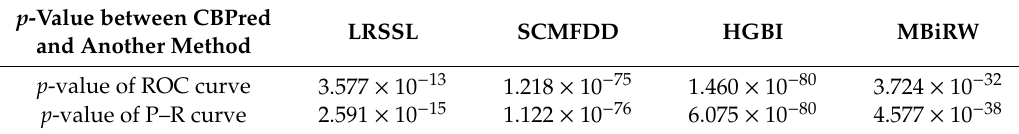
Table 3. Results of Wilcoxon test on CBPred and four other contrast methods for 763